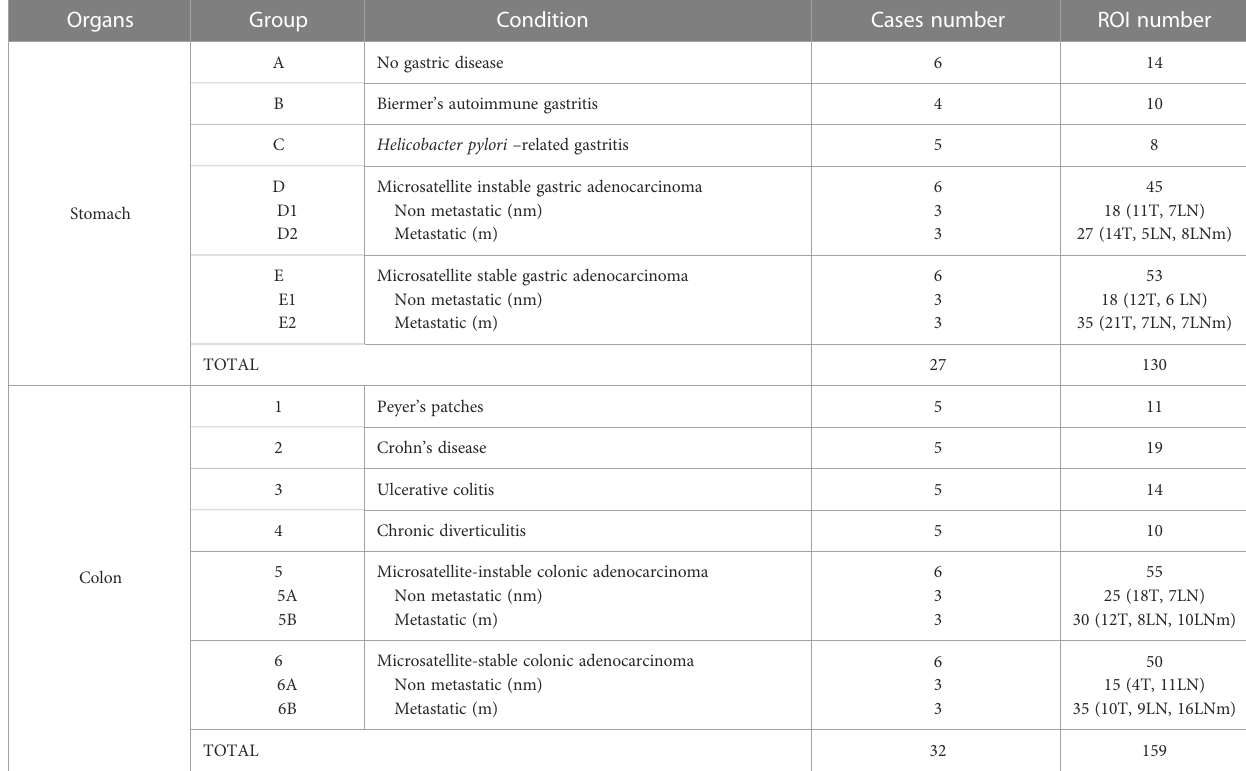
TABLE 1 Cases and regions of interest selected for imaging mass